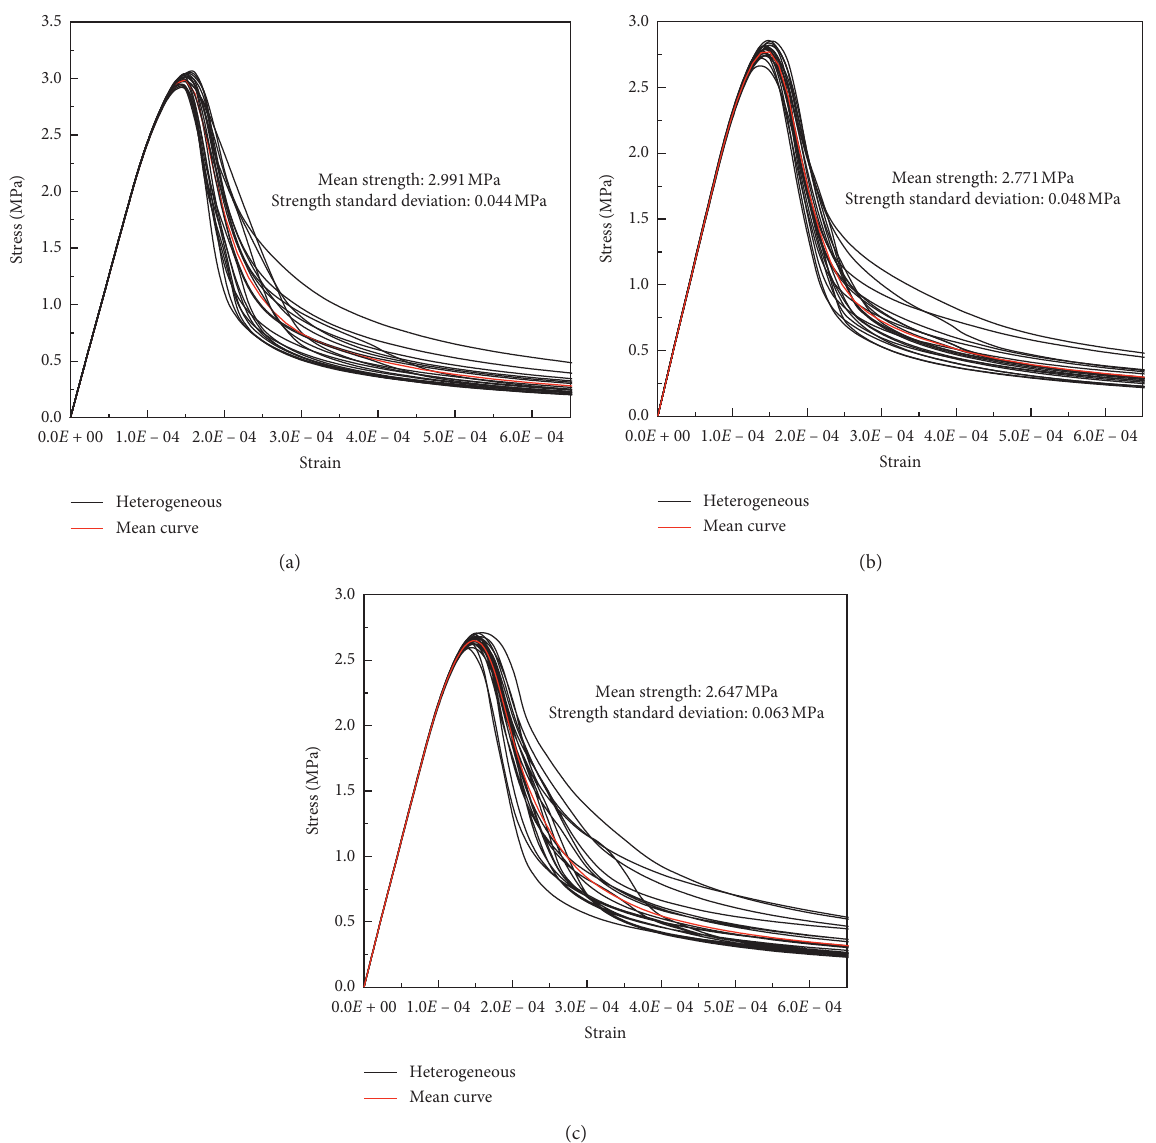
Figure 22: Stress-strain curves of rubber replacing aggregate models. (a) Rubber replace 5% aggregate. (b) Rubber replace 10% aggregate. (c) Rubber replace 15%